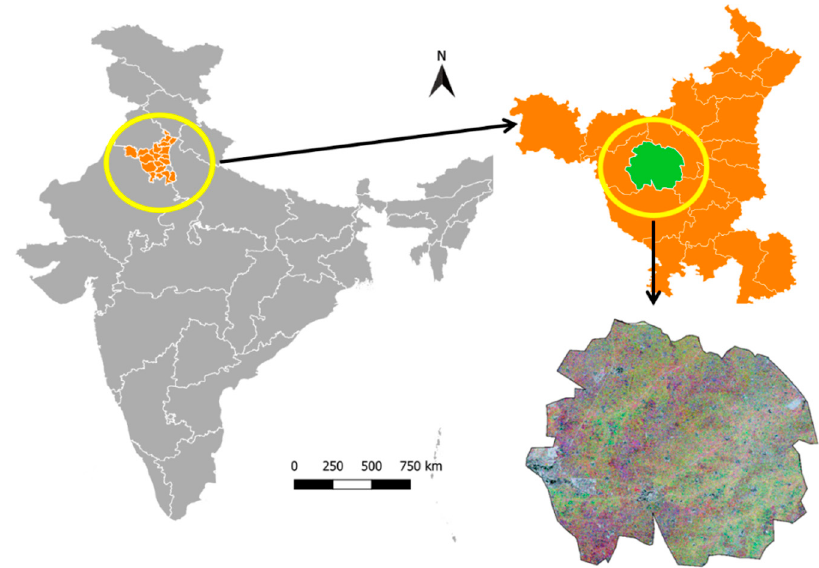
Figure 1. Study area.